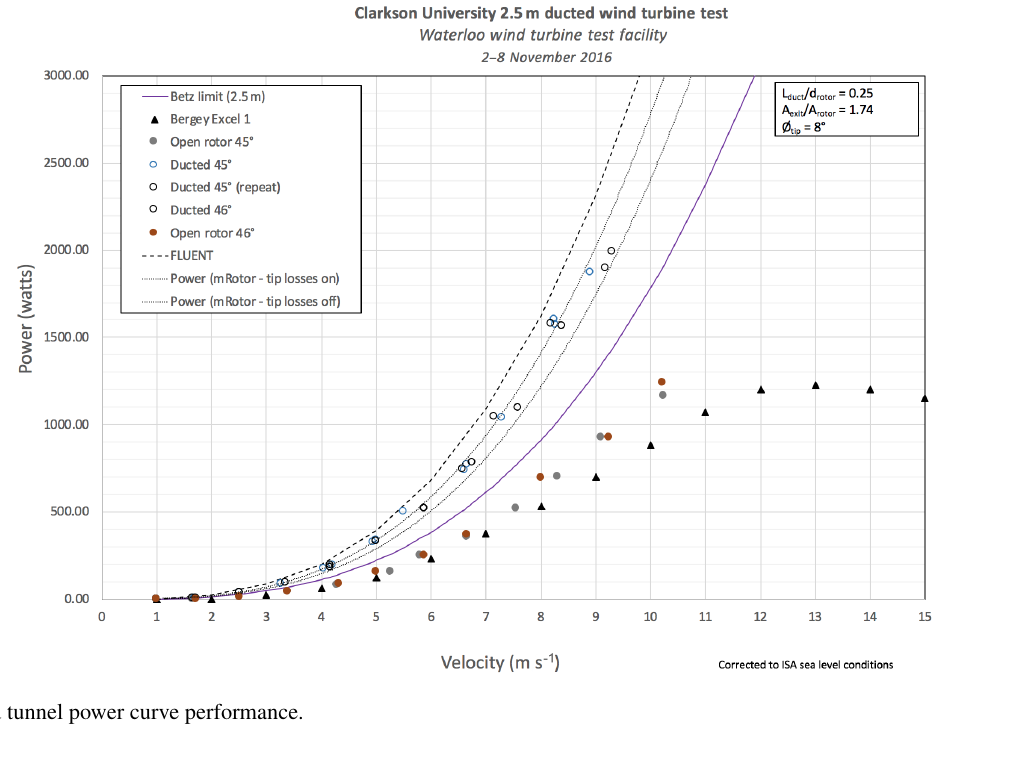
Figure 13. Wind tunnel power curve performance.